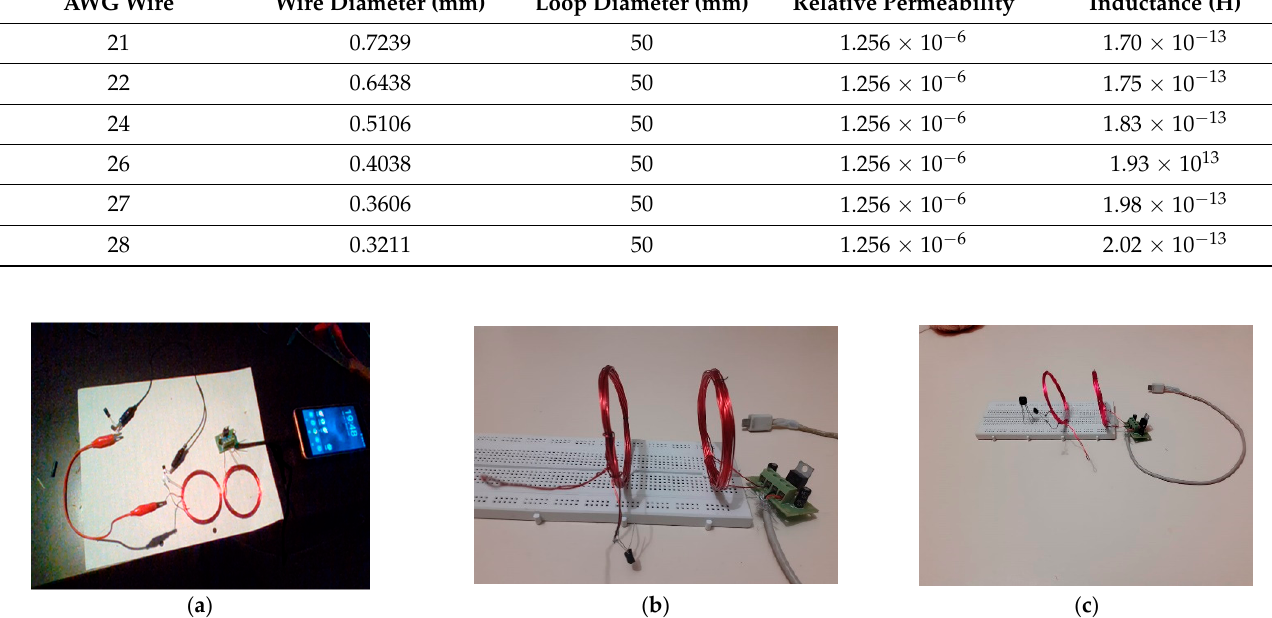
Figure 6. ( a ) Prototype circuit with the voltage rectifier connected to the coils. ( b ) MRC circuit connected to the voltage regulator. ( c ) MRC coils with the voltage rectifier component.